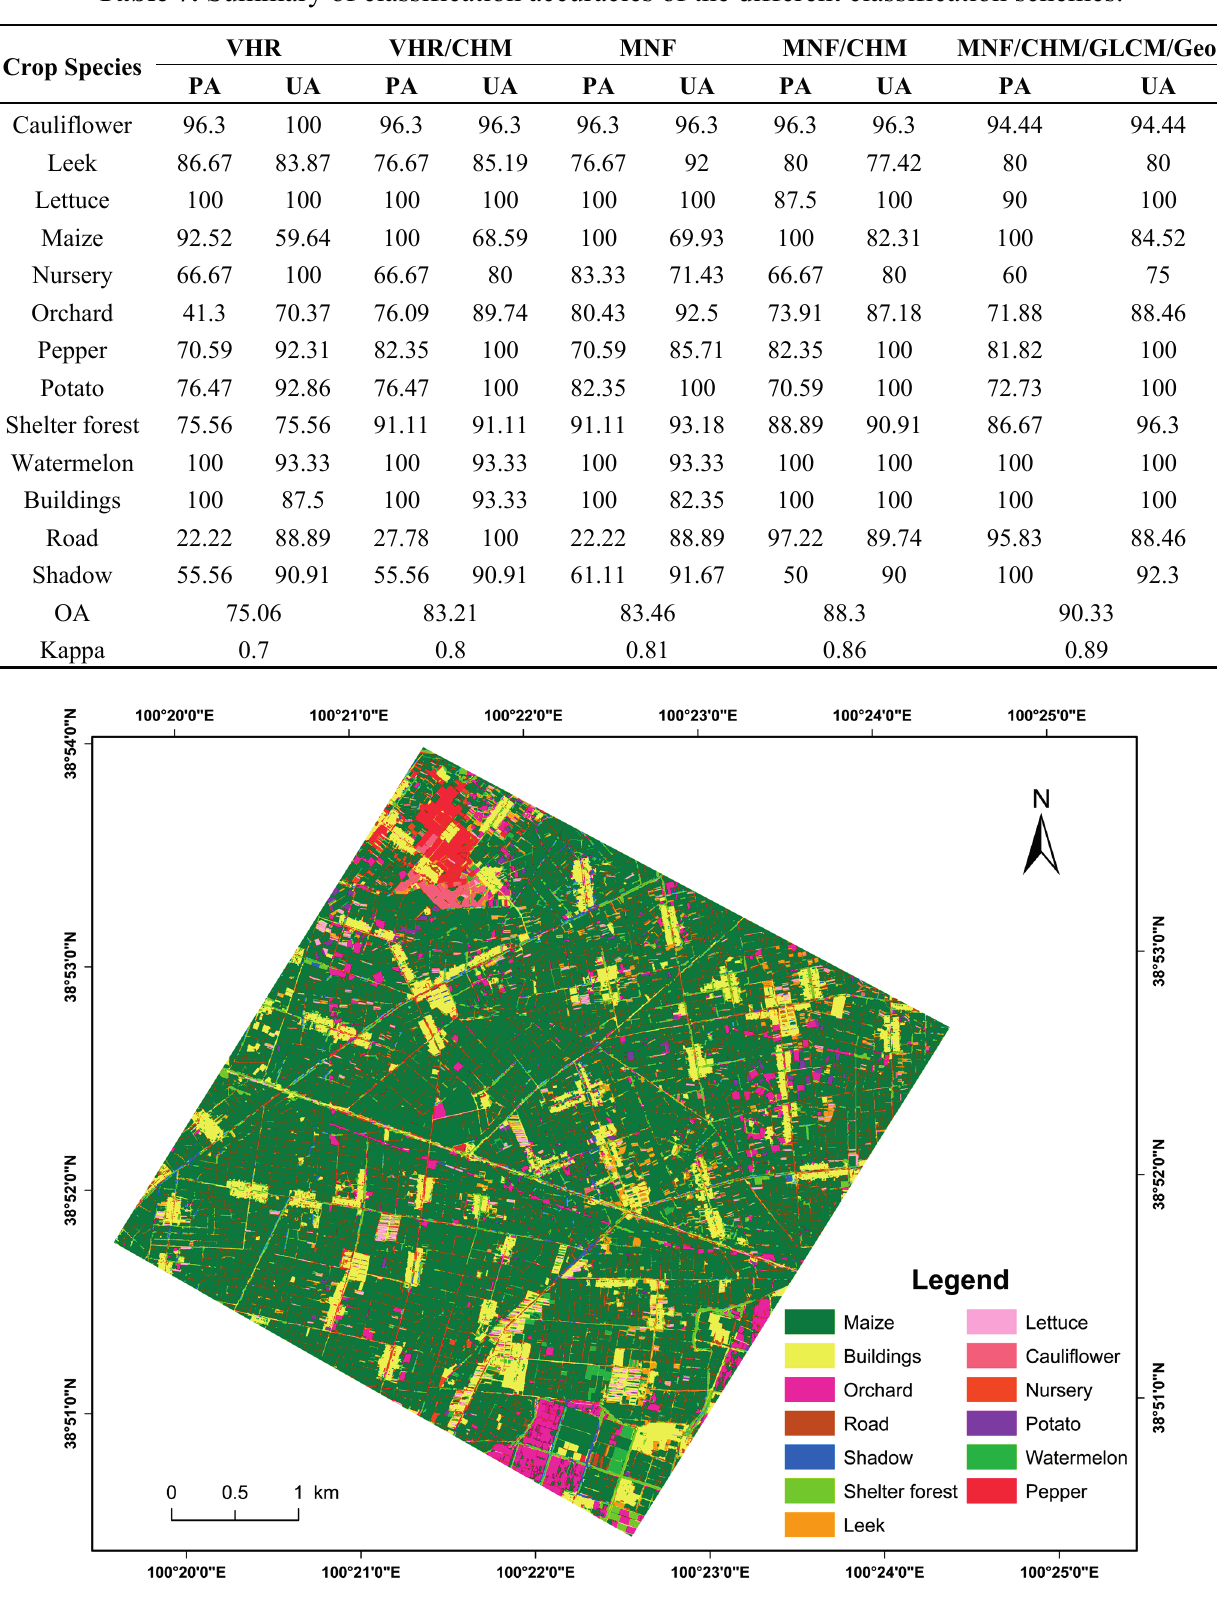
Figure 14. The crop species map classified using the combination of MNF/CHM/GLCM/Geometric features in the object-based classification